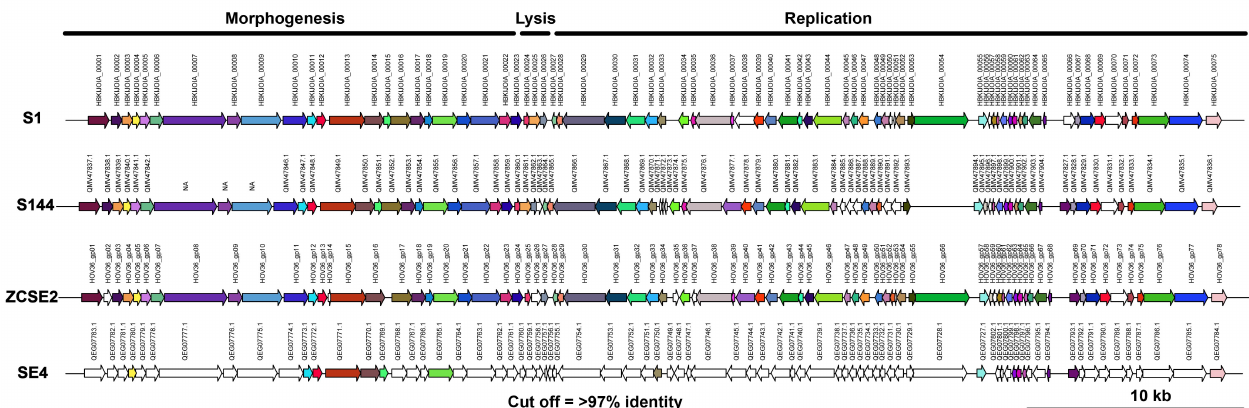
Figure 4. Genome alignment of viral proteins sharing >97% identity in phages from the genus Loughboroughvirus . From top to the bottom figures shows phage S1, S144, ZCSE2 and SE4. ORFs are shown with arrows and the number of each ORF is indicated on top of the arrow. Arrows with the same colors among all phage genomes represents homologous proteins sharing >97% identity. White arrows show <97% identity with any other protein. Arrows to the right indicate forward sense and arrows to the left indicate reverse